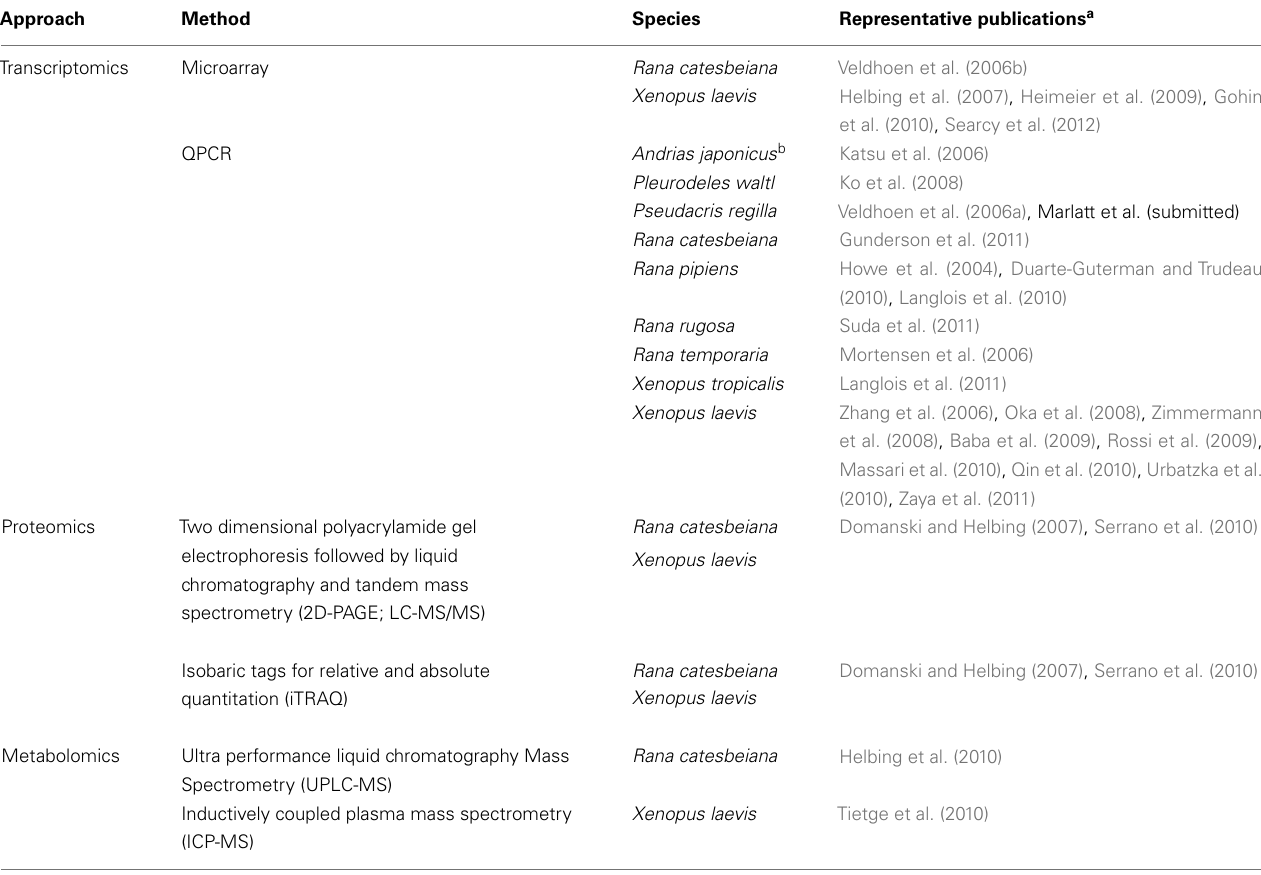
Table 1 | Representative studies using amphibian